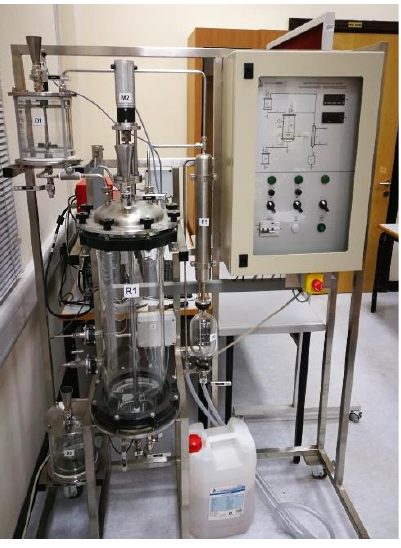
Figure 3. The pilot plant (UPB/EV-Elettronica Veneta) used in biodiesel production.